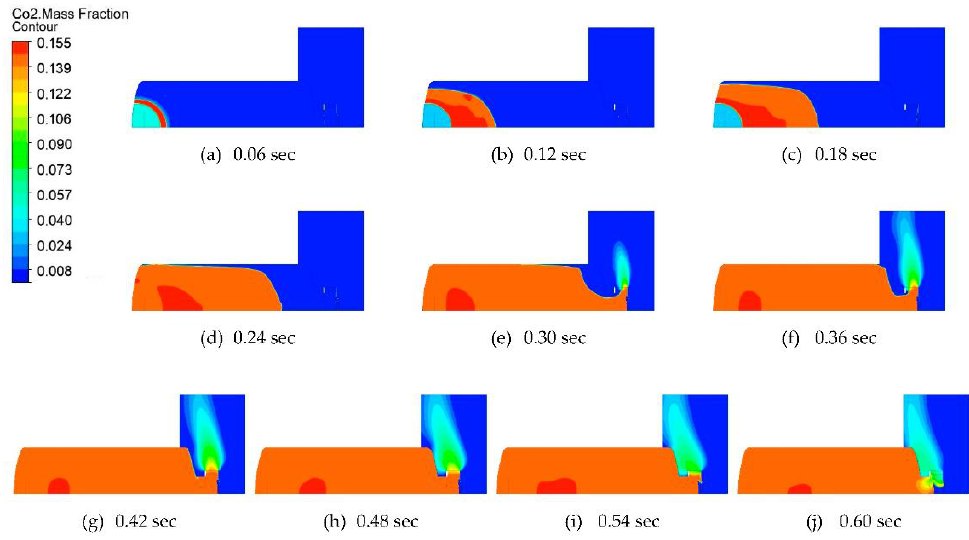
Figure 6. CO 2 Mass Fraction contour in the tank after explosion.